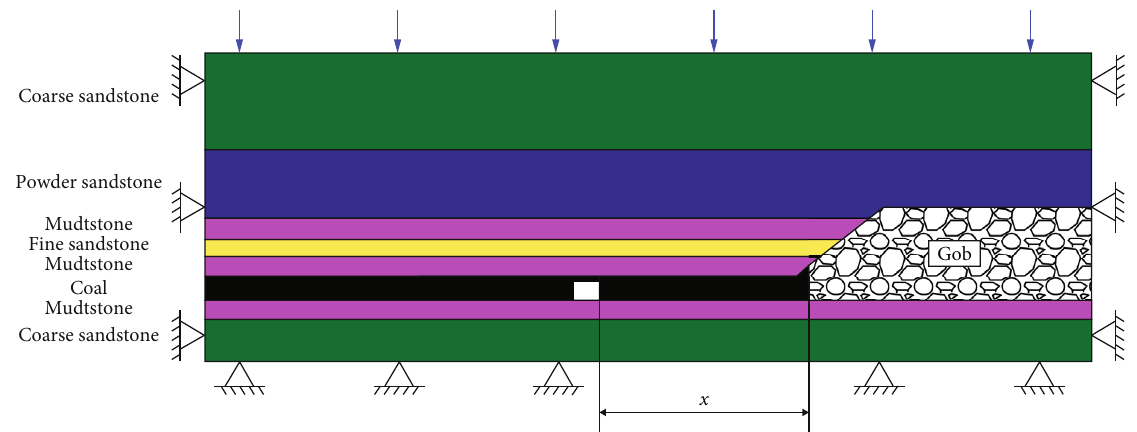
Figure 11: Diagrams of simulation schemes for di ff erent coal